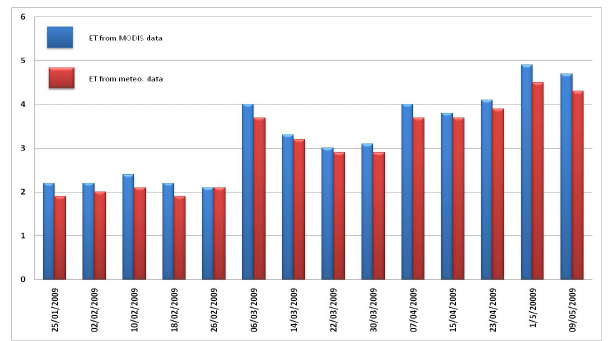
Fig 2. Crop evapotranspiration using meteorological and satellite data. Fig. 2. Crop evapotranspiration using meteorological and satellite data.